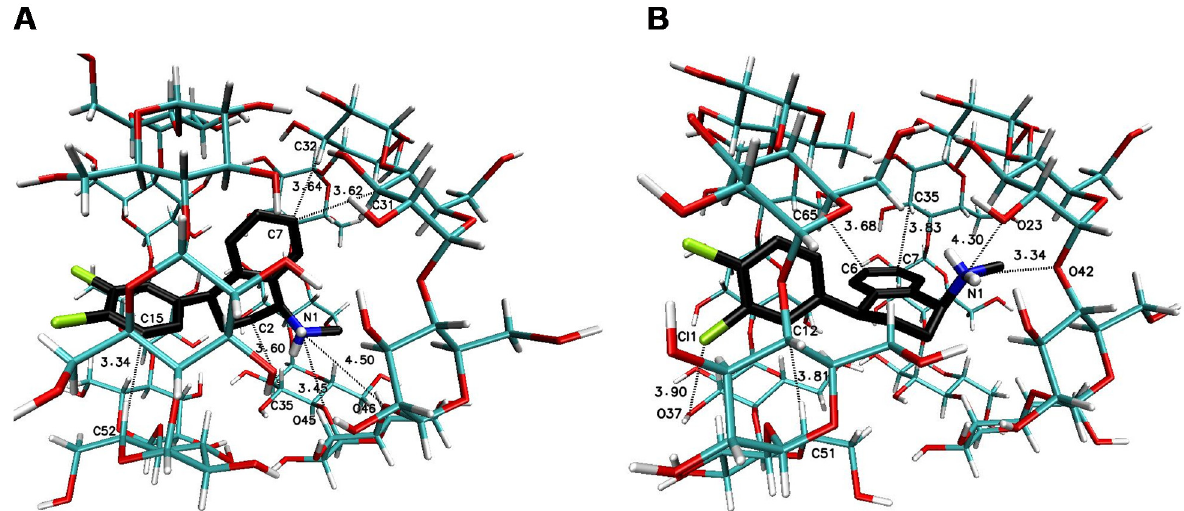
Figure 8. The geometries of the SRT- β CD complex with stoichiometry 1:2 (I-II for ( A ) or “head-to-head” [69,70] and II-III or “head-to-tail” for ( B ) obtained by MD simulations with the use of β CD crystal structure with refcode 648855 [67] from the CSD database [47].